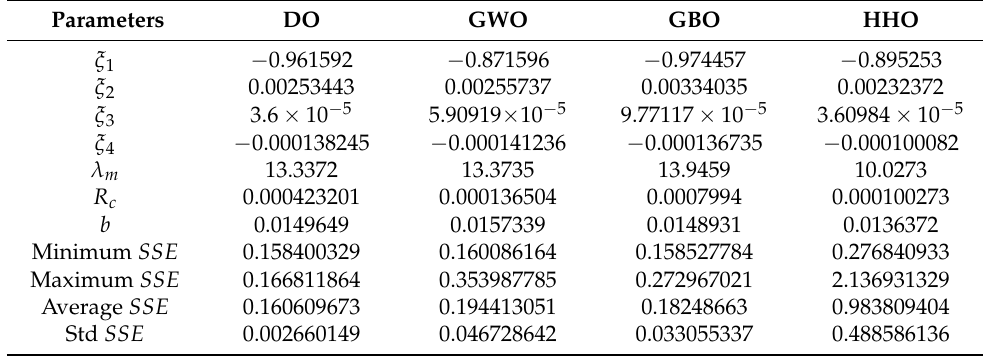
Figure 3. Convergence curve of fitness function: ( a ) 250 W fuel cell; ( b ) NedStack PS6 fuel cel. Table 3. Optimal parameters of PEMFC 250 W.